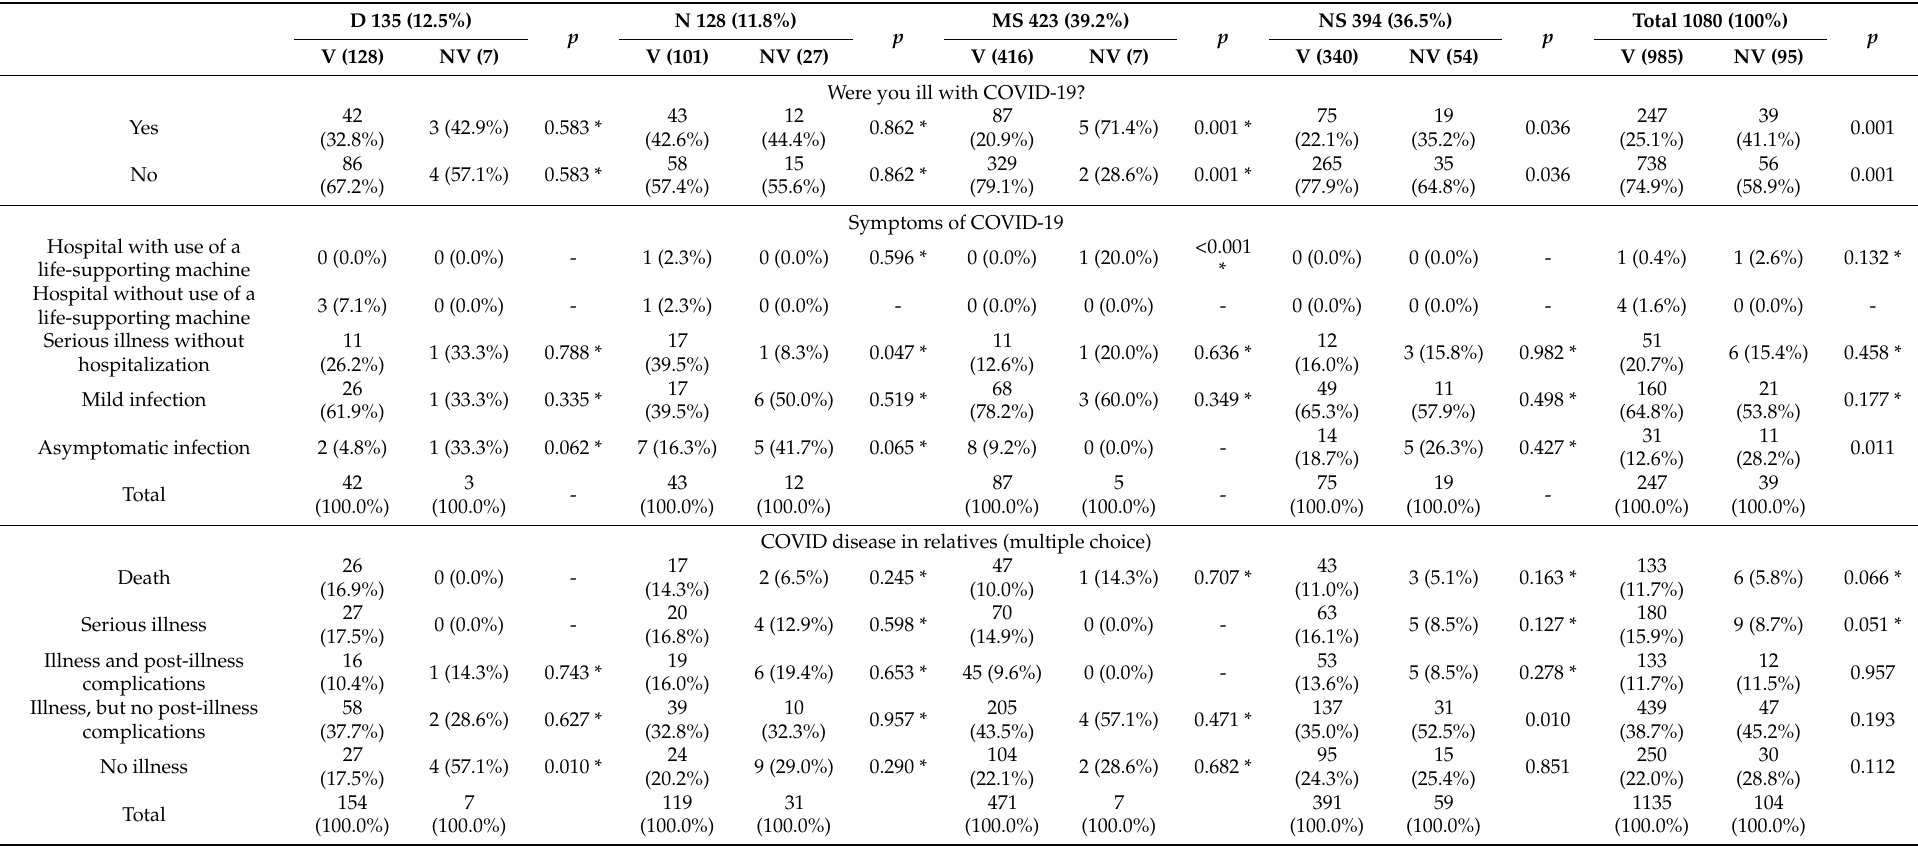
Table 2. Incidence and symptoms of COVID-19 among respondents and their